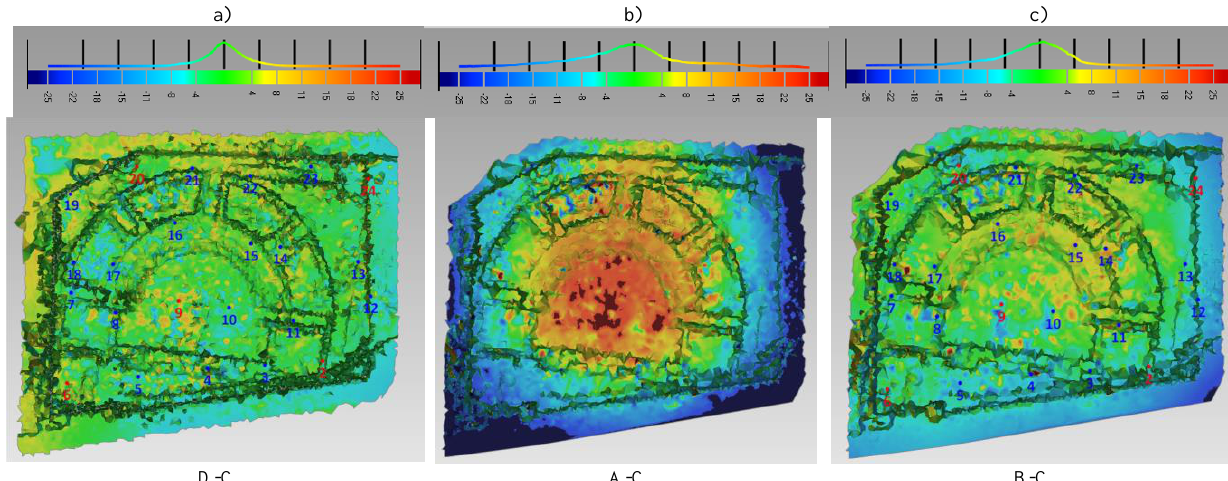
Figure 8: Euclidean distances between the computed 3D coordinates in the different bundle adjustment computations and network configurations (named version A, B, C and D as in Section 2). The differences are in